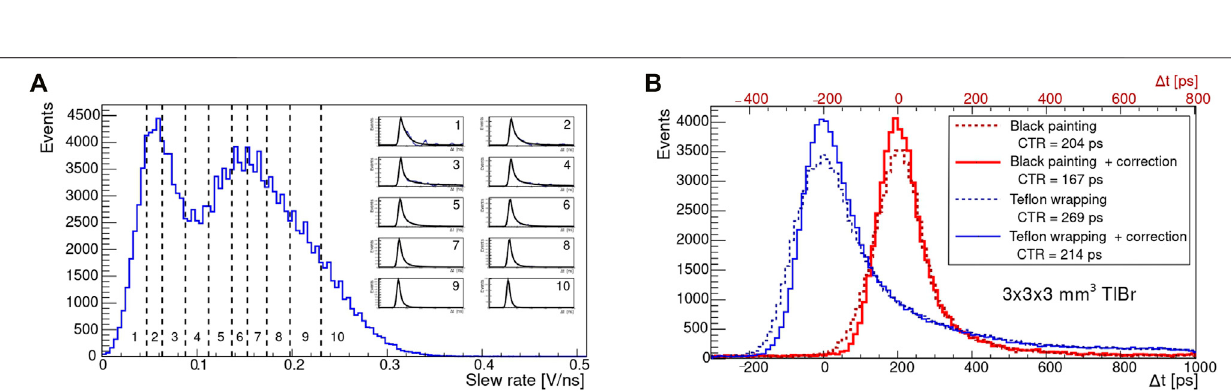
FIGURE 3 | Simulation of the re fl ection of an optical photon on a surface of the crystal. The σ α parameter allows the speci fi cation of the surface roughness. The uni fi edmodelassumesthattheprobabilityofmicro-facetnormalspopulatingtheannulusofthesolidanglesin( α )d α isproportionaltoaGaussianwithstandarddeviation σ α . The constraint on sin( α ) is de fi ned as the lower between 1 [sin( π /2)] and 4 σ α .